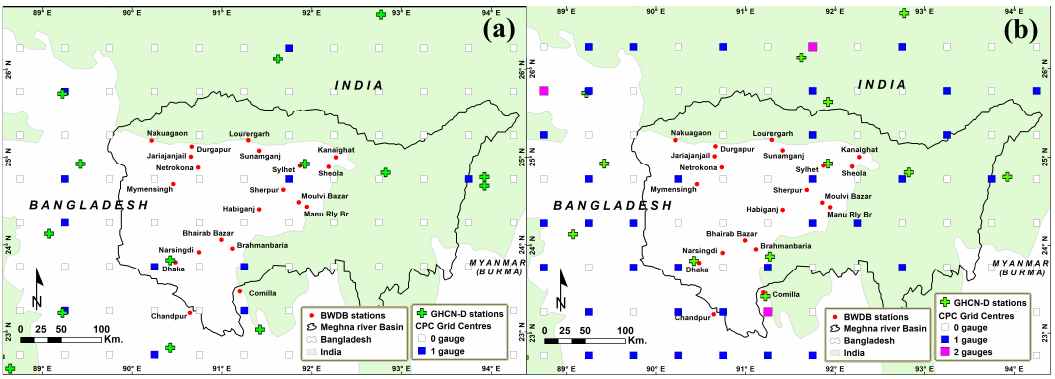
Figure 2. Meghna basin showing the GHCN-D global gauge stations and CPC unified 0.5°-grid centres that—along with other observed datasets—were used to produce the GSRP rainfall estimates on ( a ) 25 July 2010, and ( b ) 17 May 2016. The local 20 Bangladesh Water Development Board’s (BWDB) rainfall stations are also presented (red dots).